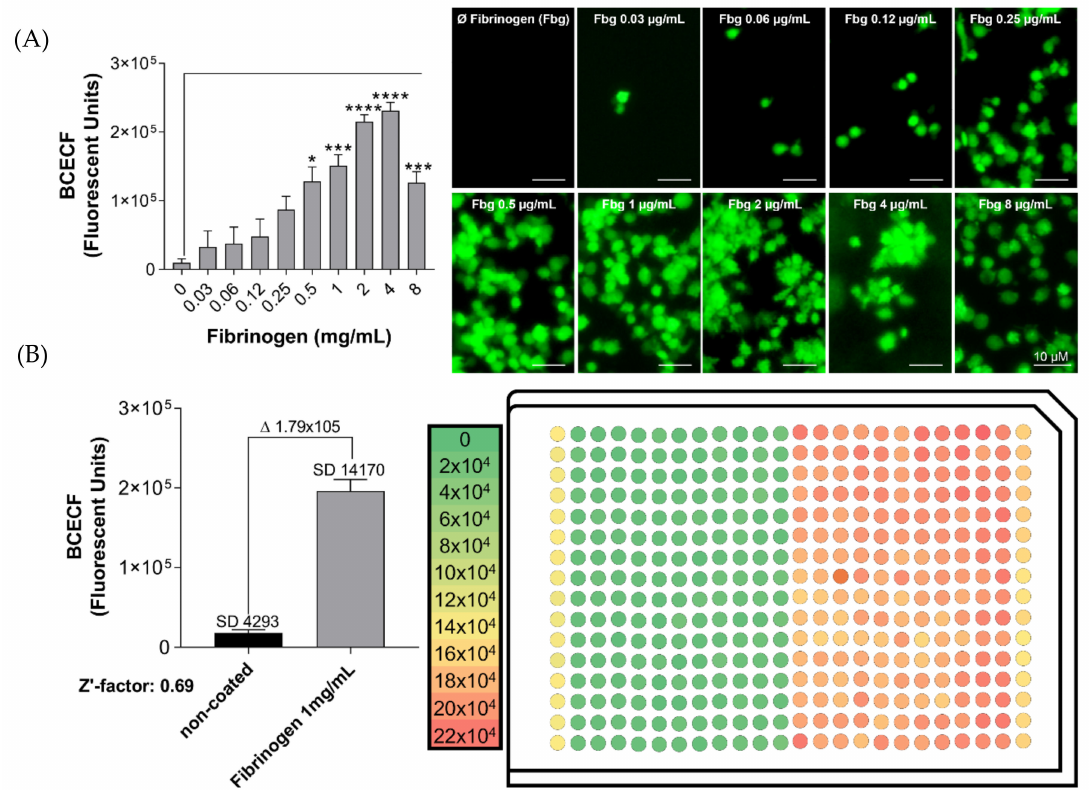
Figure 6. Z (cid:48) -factor calculation to validate the platelet adhesion assay in a 384-well microplate. ( A ) Platelet adhesion similarity between 96- and 384-well microplates. Coating of 384-well microplate with di ff erent concentrations of fibrinogen (Fbg 0.03 to 8 mg / mL in 20 µ L), or incubation with distillated water, were performed for 1 h at 37 ◦ C. After blocking the wells with BSA (0.03%), human washed platelets (8 × 10 4 / µ L in 10 µ L) were added, followed by incubation for 1 h at 37 ◦ C. Next, non-adherent platelets were removed, and adherent platelets were incubated with BCECF-AM (4 µ g / mL in 20 µ L) for 30 min at 37 ◦ C. Fluorescence intensity was measured using a plate reader (VictorX, PerkinElmer, Waltham, MA, USA). Values were compared with the control condition (non-coated plastic) by one-way ANOVA followed by Dunnett’s post hoc test (* p < 0.05, *** p < 0.001, **** p < 0.000,1 values presented as SEM resulting from duplicate average of four independent experiments). Images were acquired using a fluorescence microscopy (Eclipse Ti2, Nikon) with a 20x objective. ( B ) Z (cid:48) -factor calculation to validate the platelet adhesion assay. In a 384-well microplate, 20 µ L of water were added to half of the microplate (176 wells—left side). In the other half, fibrinogen (1 mg / mL) diluted in water was added (176 wells—right side). After blocking the wells with BSA (0.03%), human washed platelets (8 × 10 4 / µ L in 10 µ L) were added, followed by incubation for 1 h at 37 ◦ C. Next, non-adherent platelets were removed, and adherent platelets were incubated with BCECF-AM (4 µ g / mL in 20 µ L) for 30 min at 37 ◦ C. As a control, platelet adhesion on plastic was measured in the first and last columns. ∆ represents delta: (Fibrinogen) − (non-coated). Fluorescence intensity (F.I.) was measured using a plate reader (VictorX, PerkinElmer, Waltham, MA, USA). The data of the graphs showing the Z (cid:48) -factor were calculated using the equation previously published by Zhang et al.